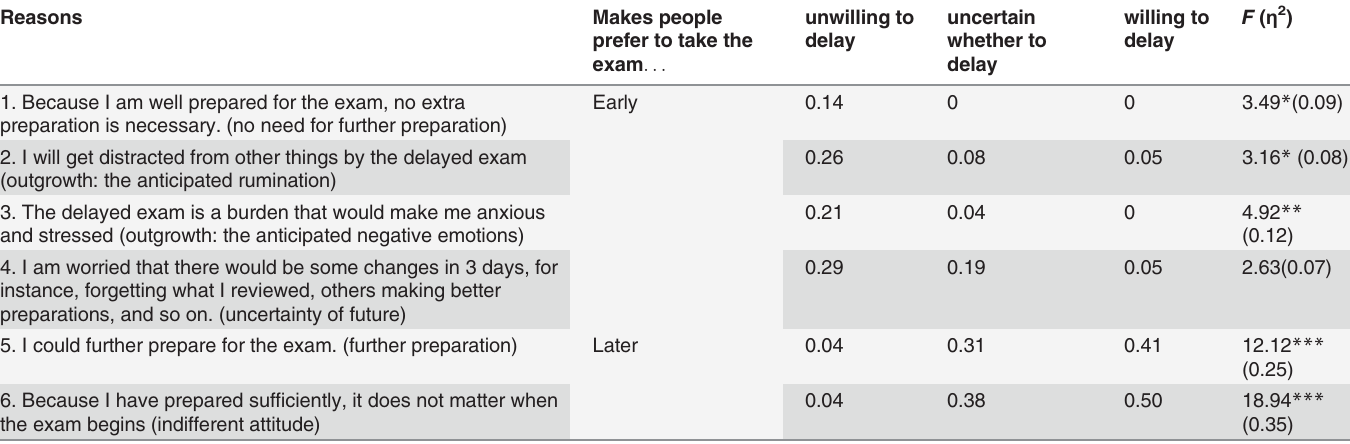
Table 2. The summary and comparison (MANOVA) of the proportion of reasons listed by participants in three groups: unwilling to delay, uncertain as to whether to delay, and willing to delay in Study 1b.